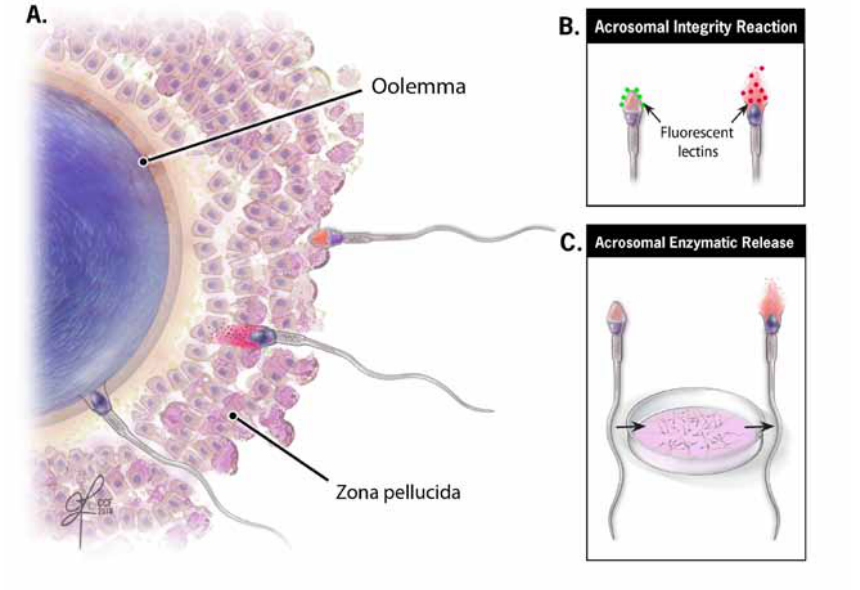
Figure 4 - (a) Normal physiology: proteolytic enzymes in the acrosome digest through the zona pellucida, allowing for sperm- -oolemma fusion. (b) Assessing acrosomal integrity: different fluorescent lectins are applied to label either the outer membrane or acrosomal contents. (c) Assessing acrosomal enzymatic release: Enzymatic release is induced and the proportion of reacted spermatozoa is assessed. Reprinted from Int J Urol. 2010; 17: 839-47. Samplaski, et al. New generation of diagnostic tests for infertility: review of specialized semen tests, with permission from publisher (John Wiley and Sons)